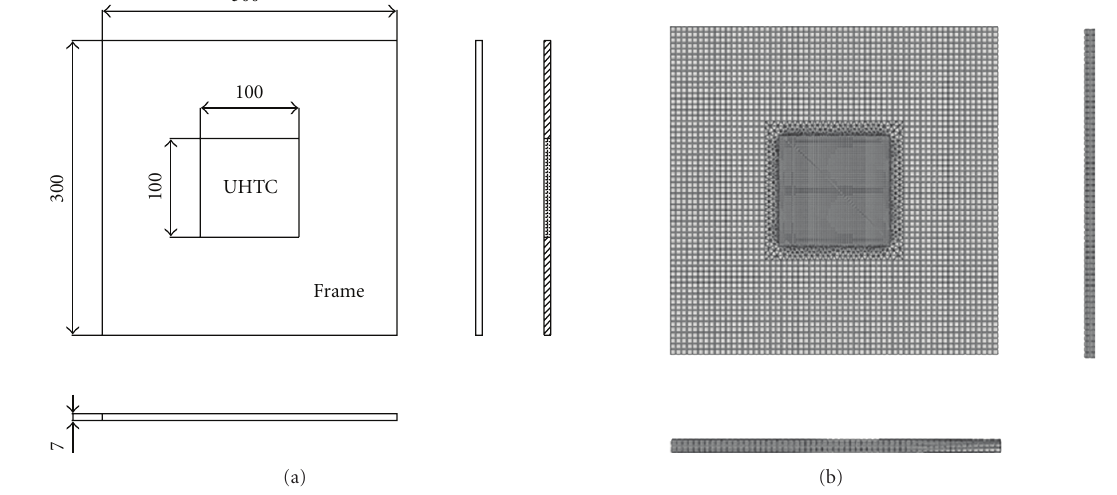
Figure 1: The orthographic views of (a) the geometric model and (b) the computational mesh.